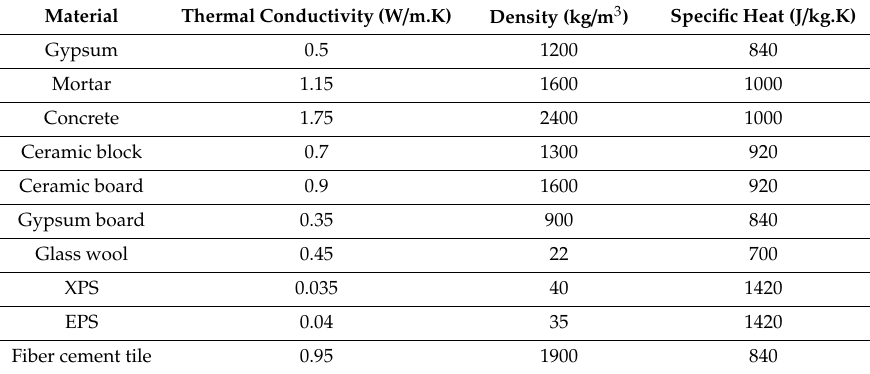
Table 19. Thermal properties of the materials used in thermal performance modeling.